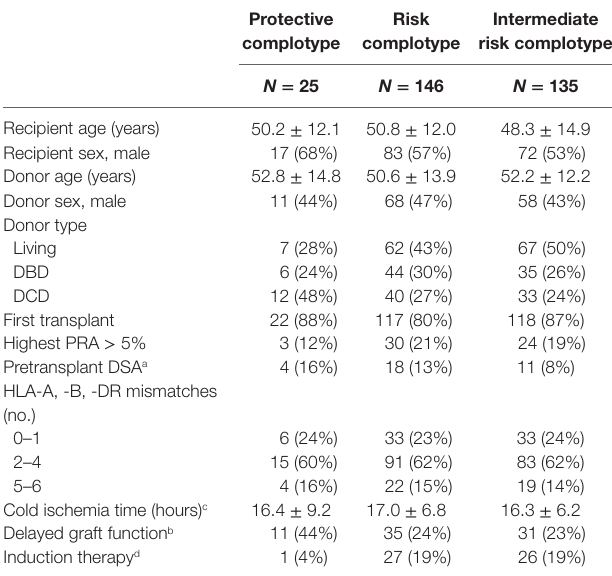
TaBle 4 | Baseline characteristics according to donor